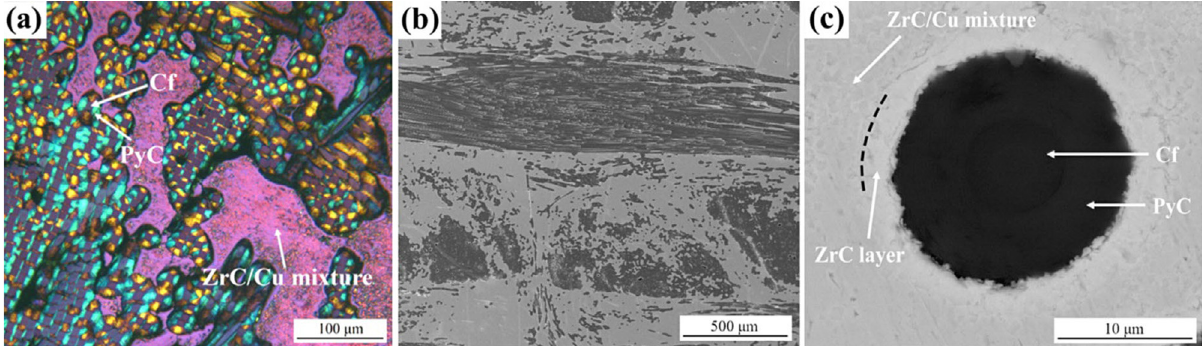
Figure 3: Microstructure images of C/C – ZrC composite prepared by RMI using Zr/Cu powder [ 59 ] : ( a ) optical micrograph; ( b ) SEM macrograph; ( c ) SEM micrograph of a representative single fi